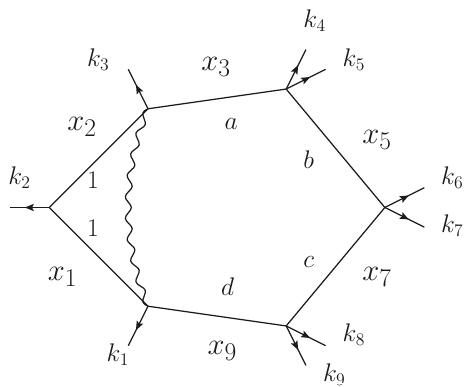
Figure 4 . One-loop hexagon integral with chiral numerator [˜ λ tions, λ i = k i = x i − 1 i | i | chiral numerator is four-dimensional. Pairs of on-shell momenta are used to represent an off-shell